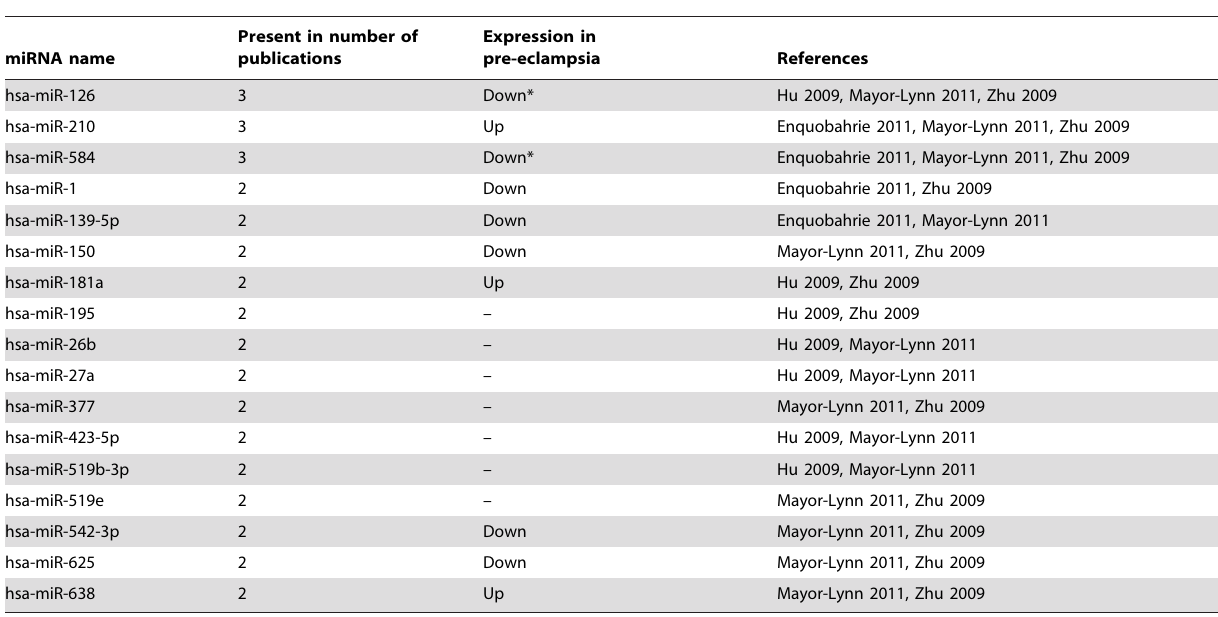
Table 2. Meta signature of 4 studies on third-trimester placental tissue microRNA